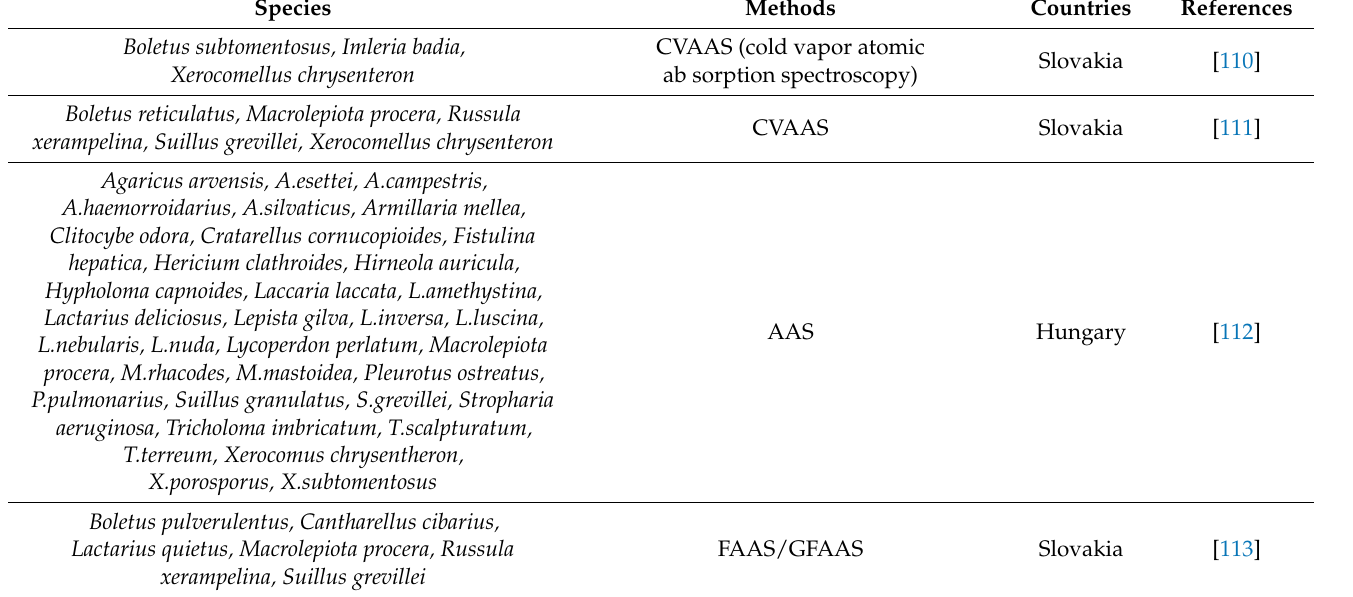
Table 9. Species, methods for determination of mercury, and countries in the literature. Species